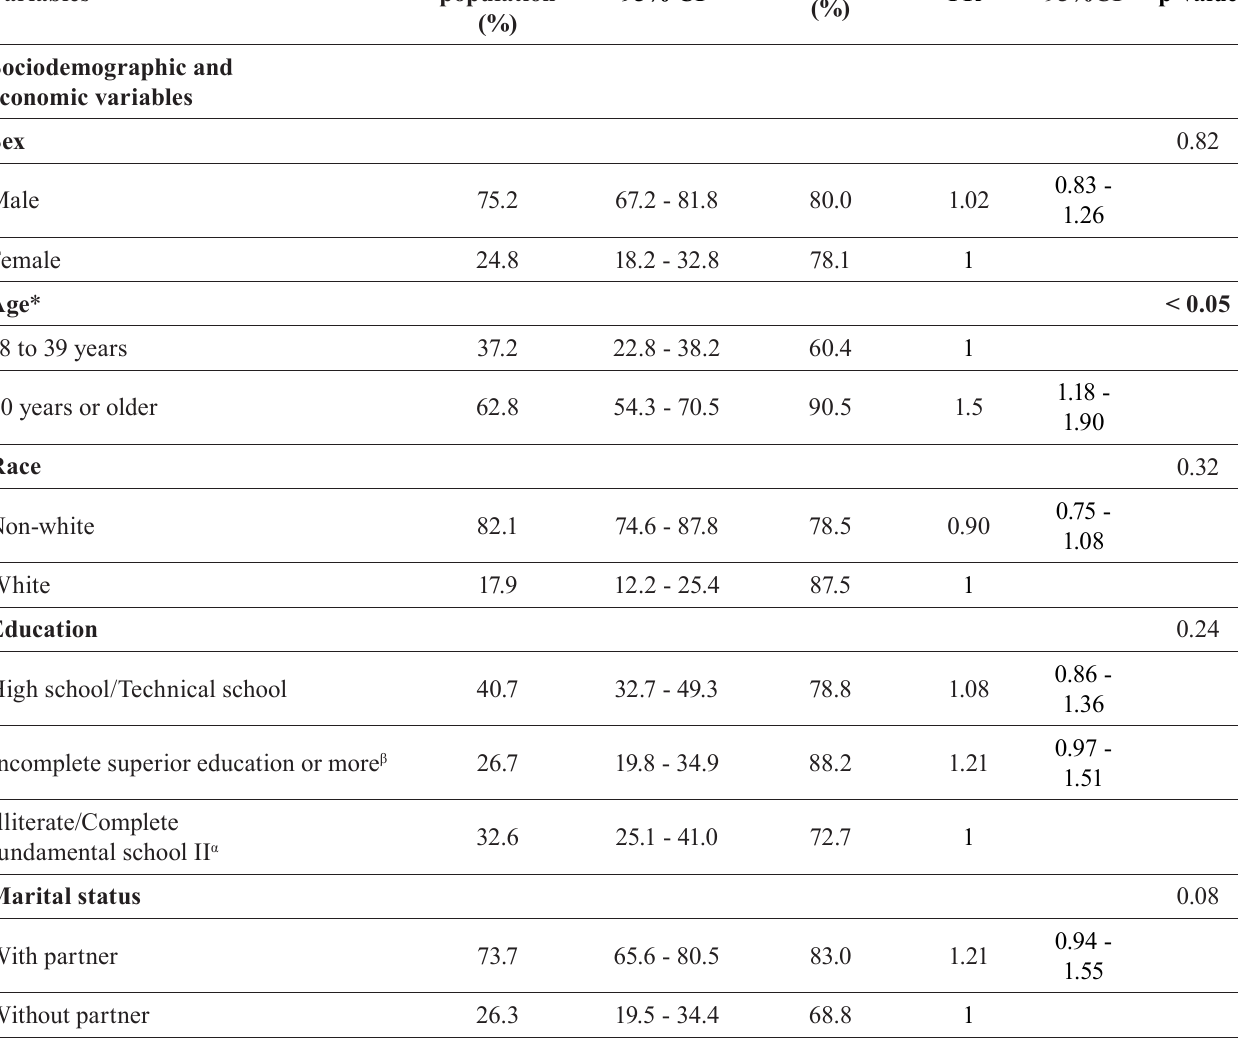
TABLE I - C haracteristics of the population of industry workers with hypertension and diabetes mellitus, prevalence of adherence and associated factors, 2017 to 2018